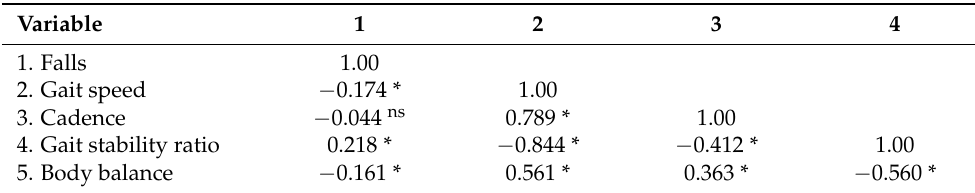
Table 2. Correlation matrix coefficients between the studied